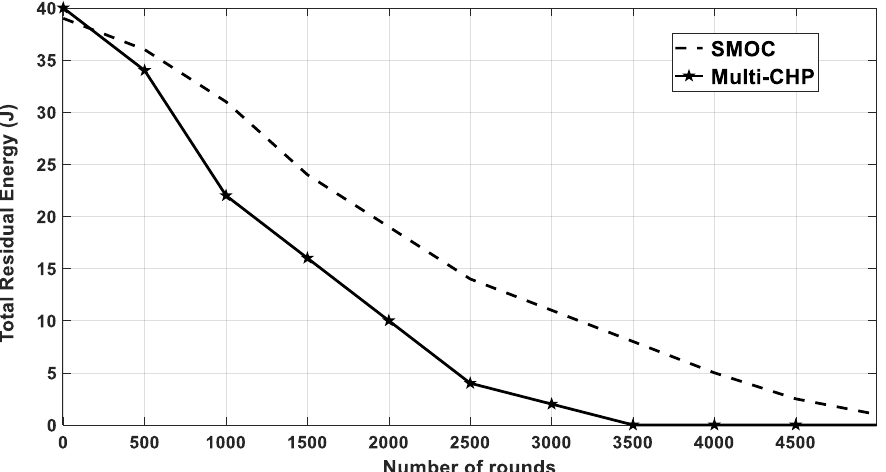
Figure 20. The average residual energy as a function of simulation rounds for multi-CHP and spiral mobility based on optimized clustering (SMOC).